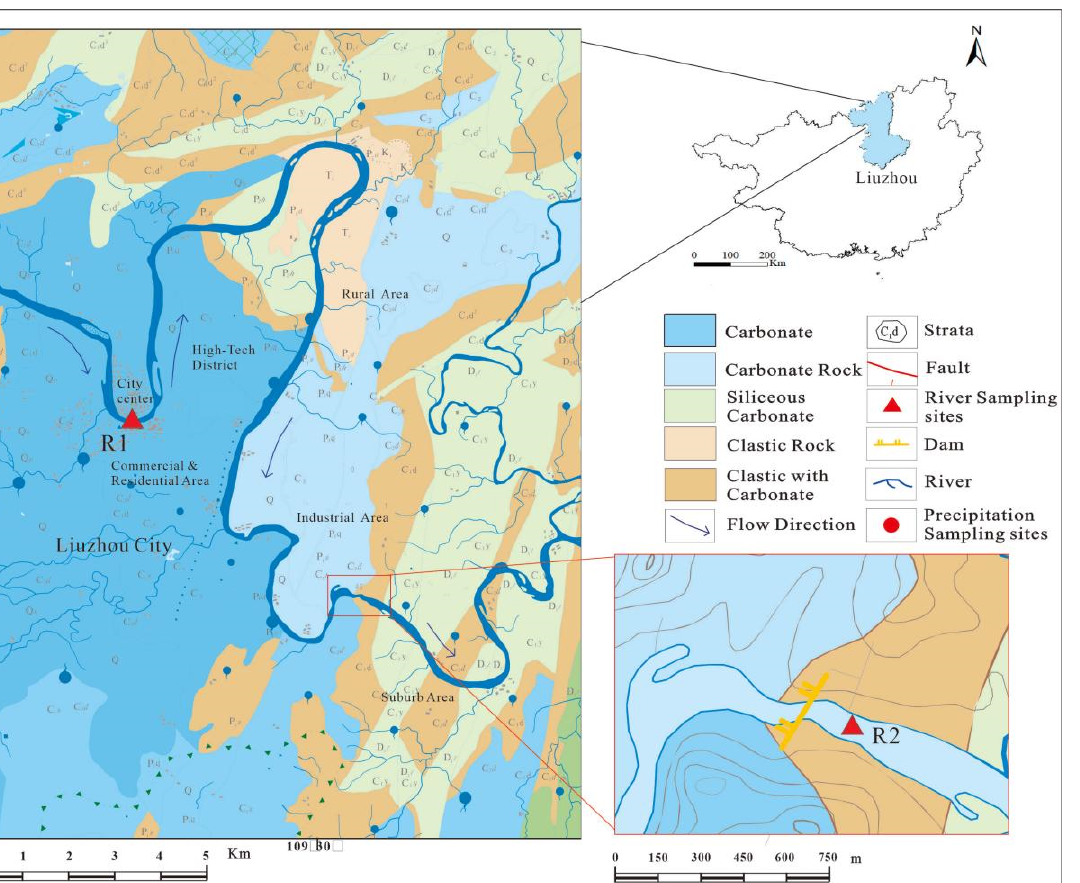
Table 1. Liuzhou annual average concentration of heavy metal pollutant statistics ( μ g/L).